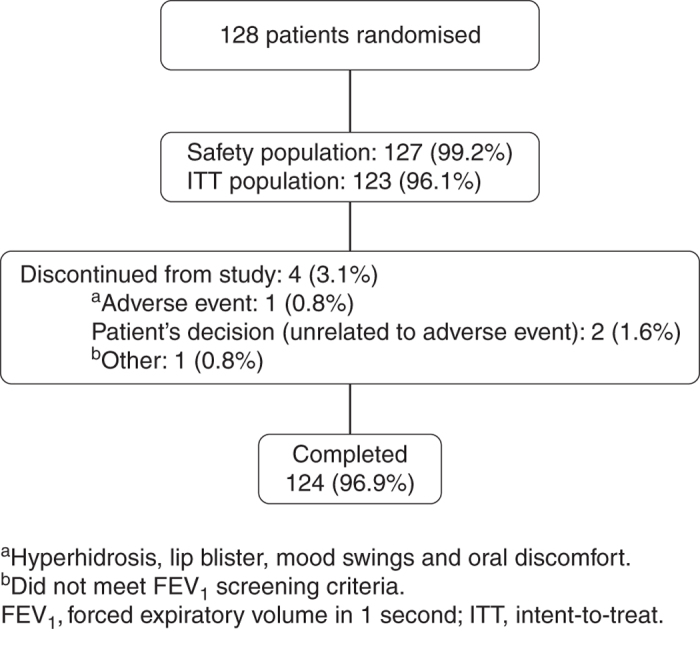
Patient disposition.